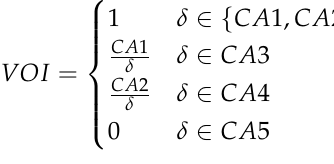
Figure 7b. The minimum value of all red and blue lines, which is the shortest distance D min of the intrusion velocity obstacle cone, was calculated. The value of TVOI was D min / v r , where v r denotes the relative speed of two